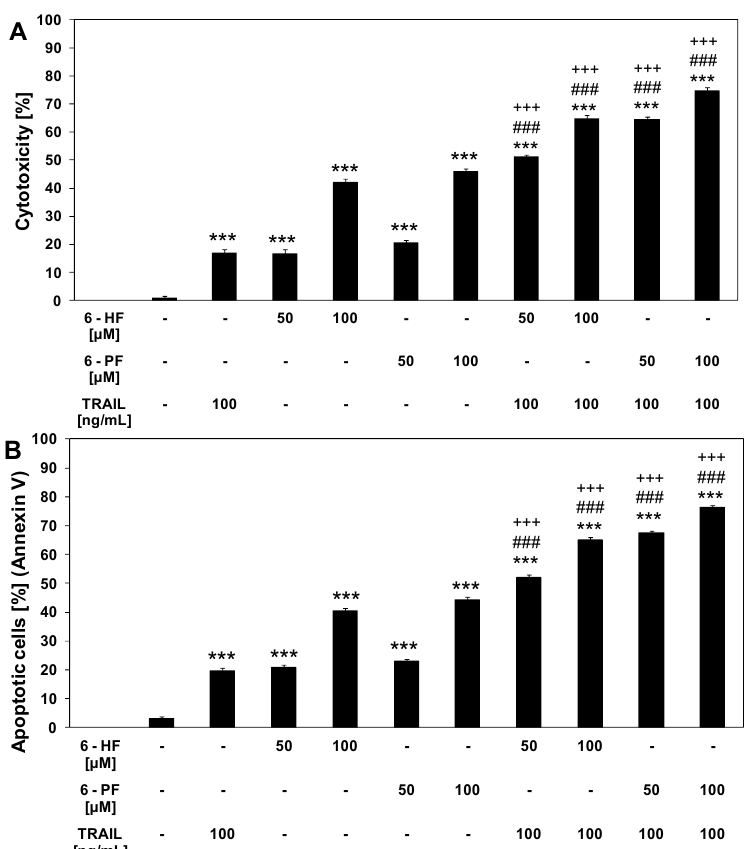
Figure 3. Cytotoxic and apoptotic activities of TRAIL in combination with synthetic flavanones in HeLa cancer cells. The cancer cells were incubated for 48 h with TRAIL at the concentration of 100 ng/mL and 6-HF or 6-PF at the concentrations of 50 μ M and 100 μ M. The values represent mean ± SD of three independent experiments performed in quadruplicate ( *** p < 0.001 compared with control, ### p < 0.001 compared with 6-HF or 6-PF and +++ p < 0.001 compared with TRAIL). (A) Co-treatment of TRAIL with flavanones induced cytotoxicity in HeLa cells. The percentage of cell death was measured by MTT cytotoxicity assay; ( B ) Co-treatment of TRAIL with flavanones induced apoptosis in HeLa cells. Detection of apoptotic cell death by annexin V-FITC and propidium iodide staining using flow cytometry; ( C ) Co-treatment of TRAIL with flavanones induced apoptosis in HeLa cells: ( a ) control cells; ( b ) cells incubated with 100 ng/mL TRAIL; ( c ) cells incubated with 50 μ M 6-HF; ( d ) cells incubated with 100 μ M 6-HF; ( e ) cells incubated with 100 ng/mL TRAIL and 50 μ M 6-HF; ( f ) cells incubated with 100 ng/mL TRAIL and 100 μ M 6-HF; ( g ) cells incubated with 50 μ M 6-PF; ( h ) cells incubated with 100 μ M 6-PF; ( i ) cells incubated with 100 ng/mL TRAIL and 50 μ M 6-PF; ( j ) cells incubated with 100 ng/mL TRAIL and 100 μ M 6-PF. Detection of apoptotic cell death by fluorescence microscopy using annexin V-FITC, Ethidium Homodimer III and Hoechst 33342 staining. The healthy cells (stained with Hoechst 33342) emitted blue fluorescence and apoptotic cells (stained with Annexin V-FITC and Hoechst 33342) emitted green and blue fluorescence (indicated by arrows). Cells undergoing apoptosis showed nuclei shrinkage, chromatin condensation and nuclei